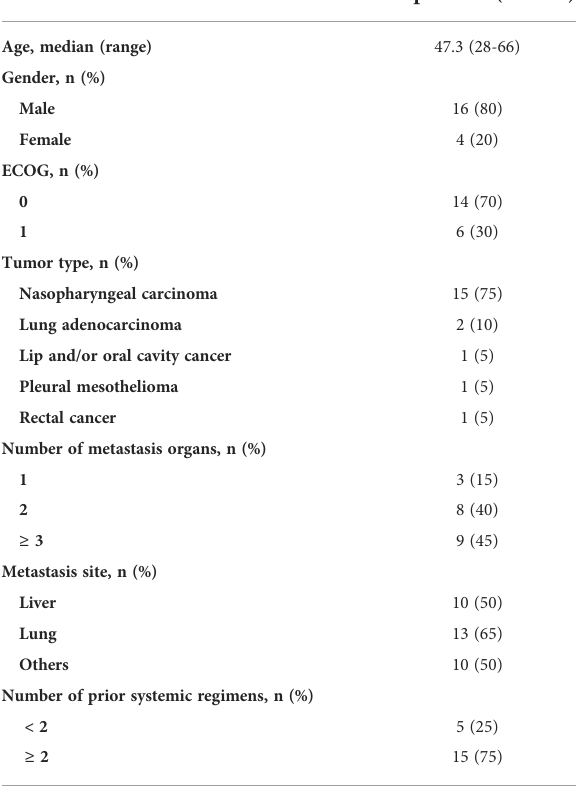
TABLE 1 Baseline patient demographics and clinical